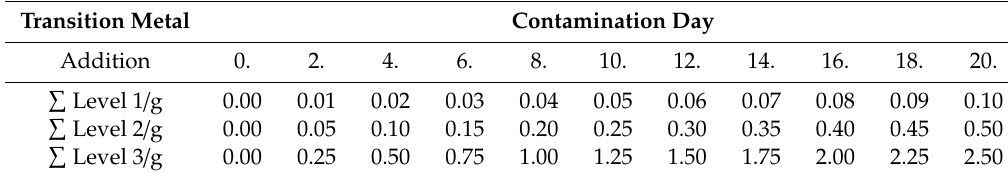
Table 4. Added transition metal cation content (Ni 2 + , Co 2 + , Mn 2 + ) in the respective irrigation water groups during a contamination time of 20 days. The total contamination of the respective transition metal for one plant was 0.1, 0.5, and 2.5